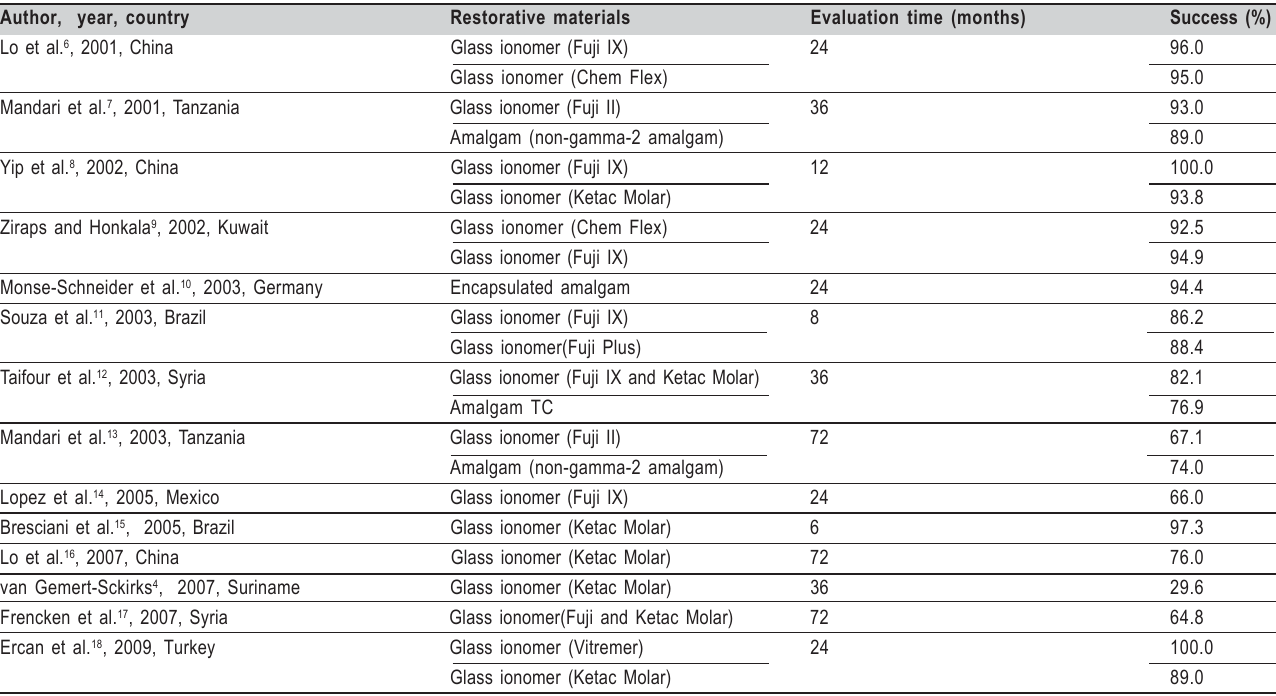
Table 2. Distribution of studies on longevity of single-surface ART restorations